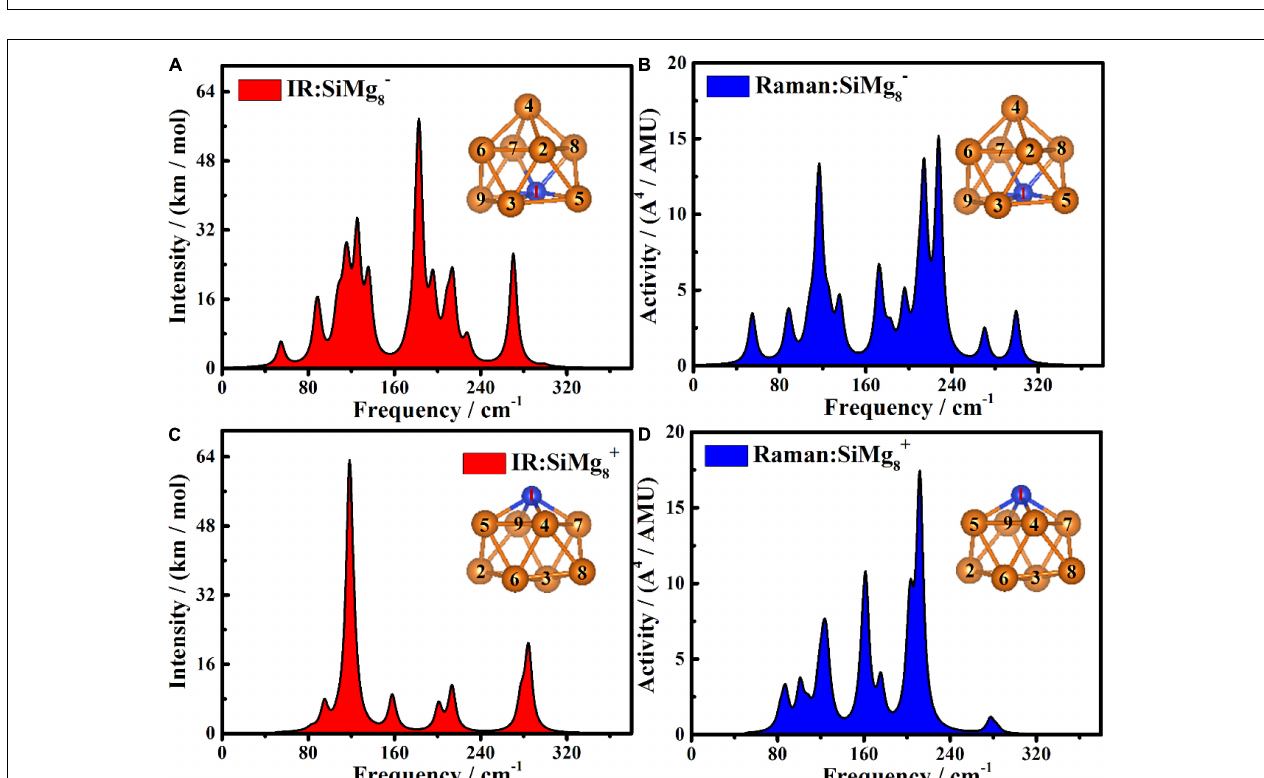
FIGURE 8 | The Infrared and Raman spectra of the most stable clusters of panels (A) IR for SiMg − 8 , (B) Raman for SiMg − 8 , (C) IR for SiMg + 8 , and (D) Raman for SiMg